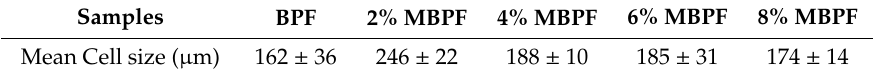
Figure 3. SEM images and cell size distributions of BPF and MBPFs: ( a ) BPF; ( b ) 2% MBPF; ( c ) 4% MBPF; ( d ) 6% MBPF; ( e ) 8% MBPF. Table 3. Mean cell size of BPF and